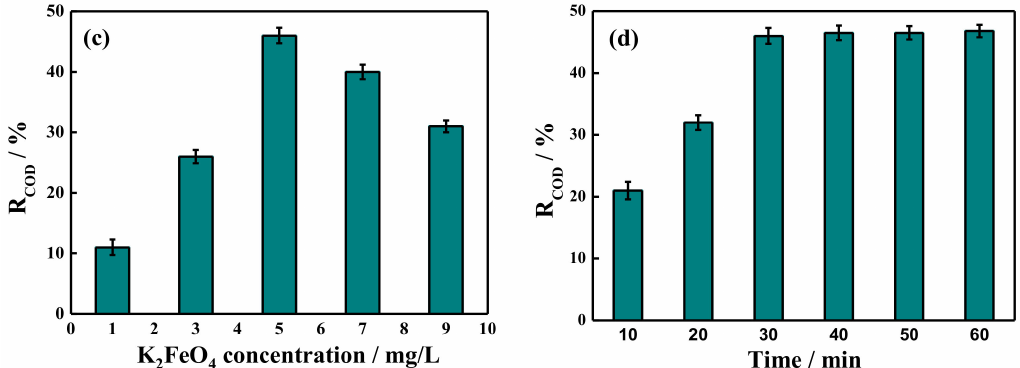
Figure 4. COD removal rate by potassium ferrate oxidation under di ff erent conditions of ( a ) pH value, ( b ) temperature, ( c ) the addition of potassium ferrate, and ( d ) reaction time.